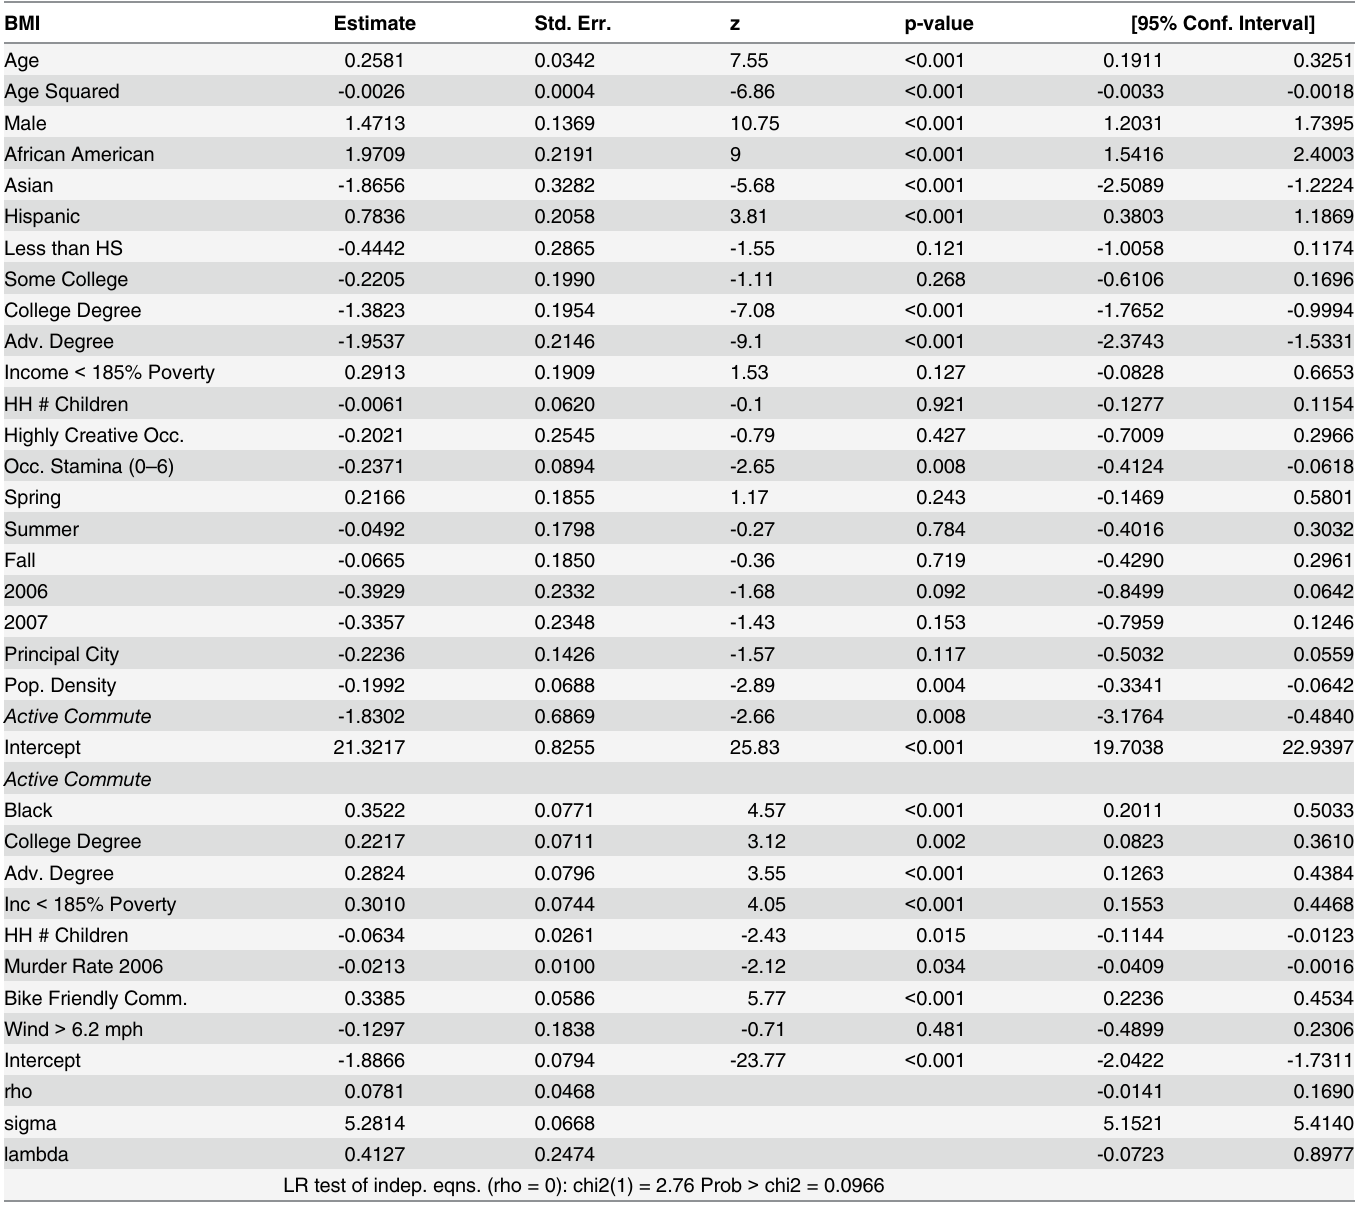
Table 6. Endogenous Treatment Effects Model: BMI Outcome Regression, Active Commute Treatment